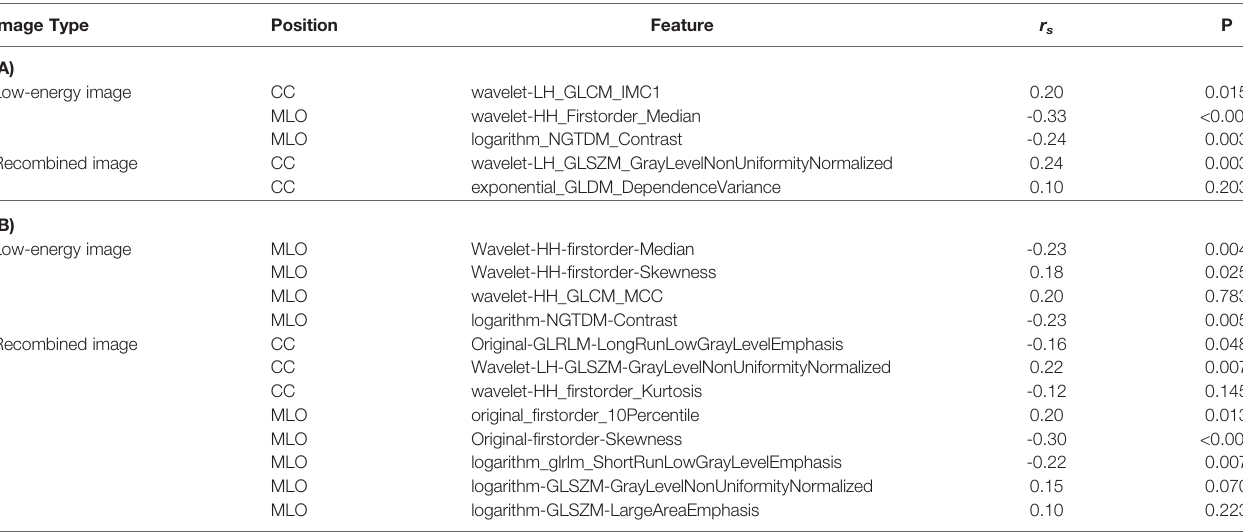
TABLE 5 | Spearman rank correlation between selected features and prediction